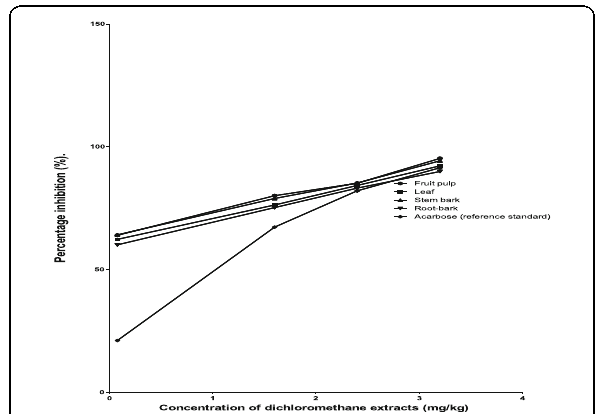
Fig. 14 Percentage inhibition of α -glucosidase by dichloromethane extract of Annona muricata fruit-pulp, leaf, stem-bark, root-bark and acarbose (reference standard)